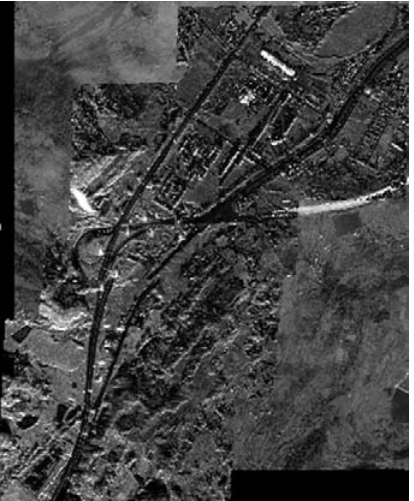
Figure 6. Sequential SAR registered images overlay with reference optical